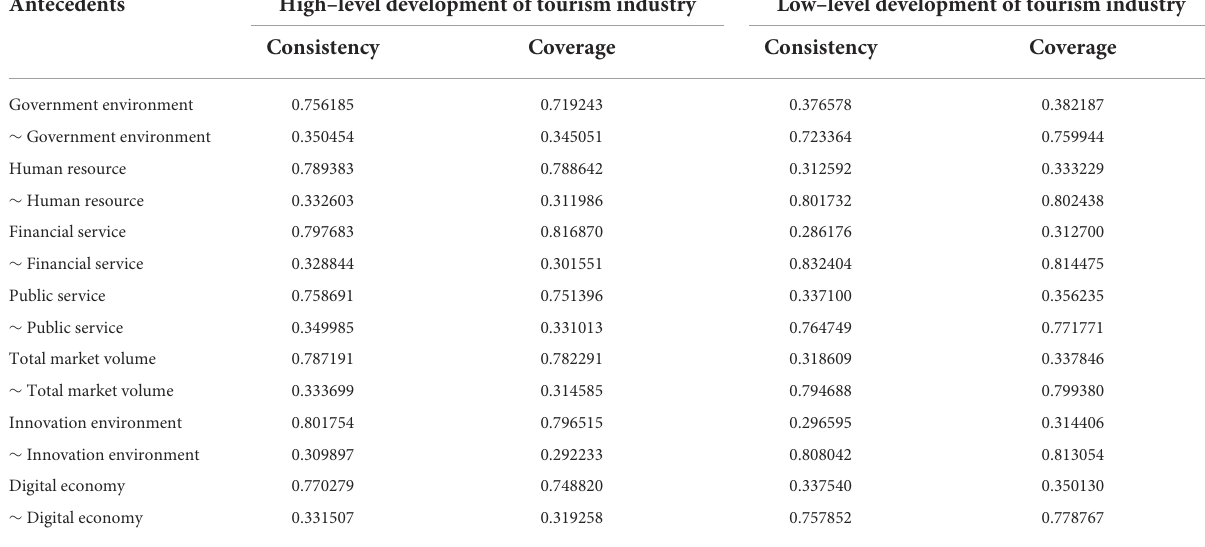
TABLE 5 Analysis of necessary conditions of fsQCA method.